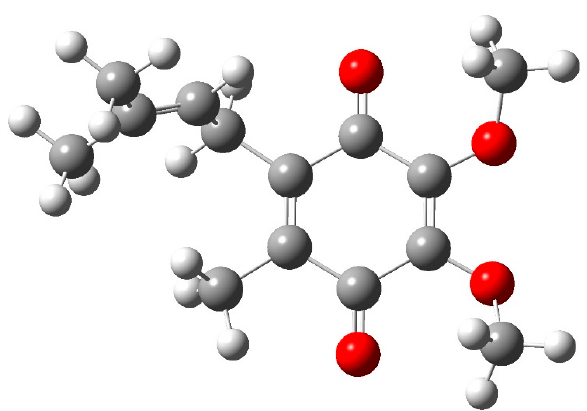
Figure 7. Model quinone molecule used for theoretical calculations of IR frequencies.